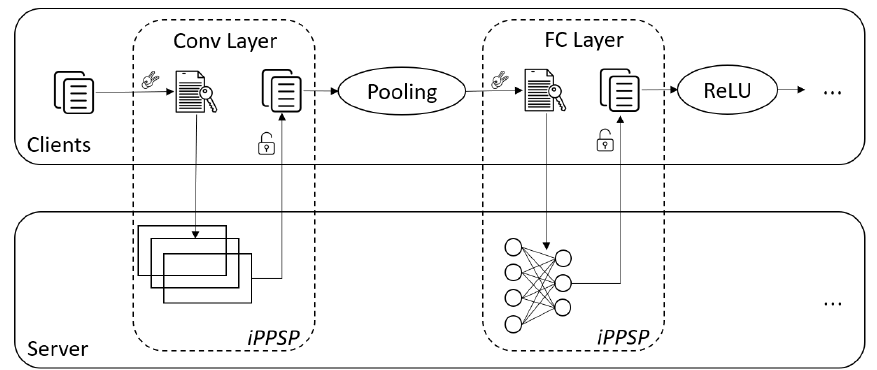
Figure 2. Framework of the proposed secure CNN inference protocol.